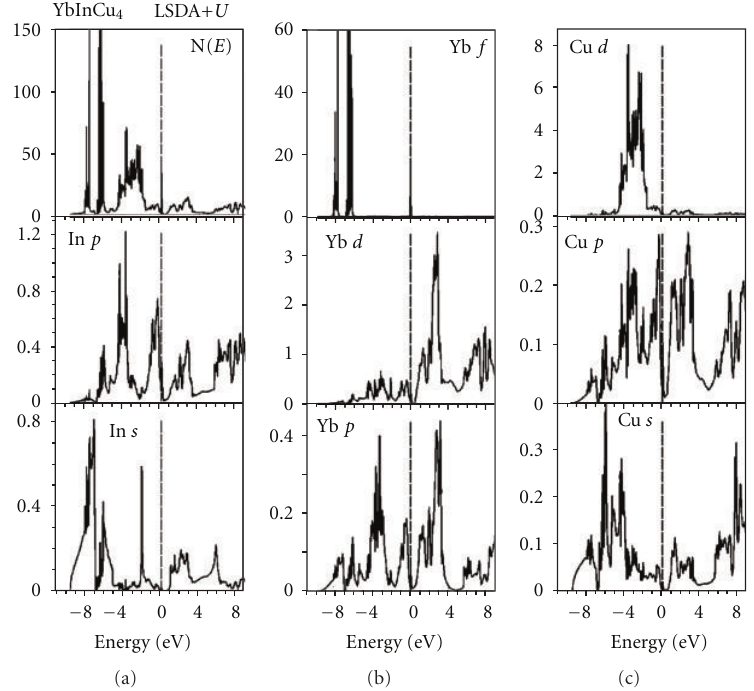
Figure 96: LSDA+ U total N( E ) (in states/(unit cell eV)) and partial DOS (in states/(atom eV)) of YbInCu 4